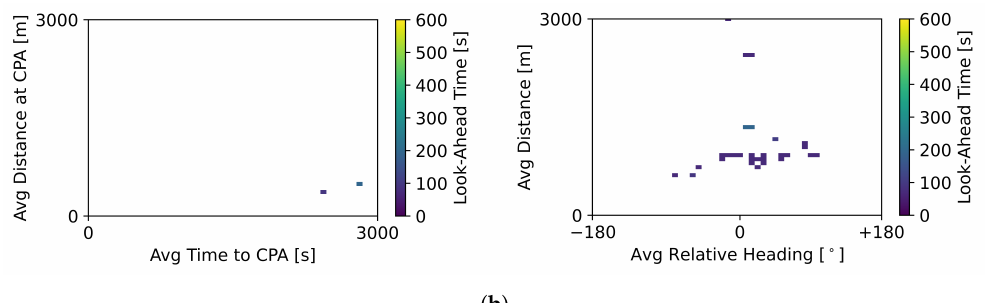
Figure 11. Situations in which only one of the methods, either ( a ) the hybrid RL + MVP method or ( b ) the baseline MVP, defended against surrounding aircraft but the other method did not. ( a ) Situations in which the hybrid RL + MVP defended against surrounding aircraft, but the baseline MVP method did not. ( b ) Situations in which the baseline MVP method defended against surrounding aircraft, but the hybrid RL + MVP method did not.